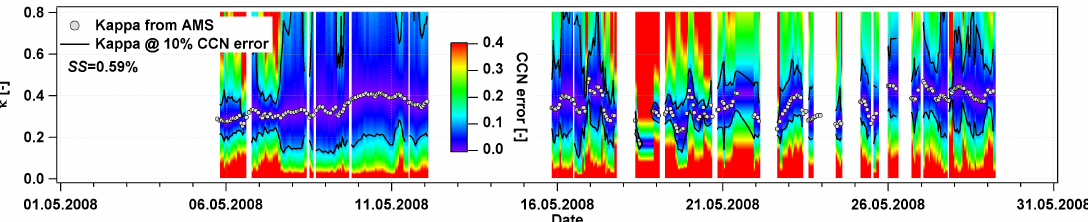
Fig. 7. Sensitivity of the prediction to the κ at 0.59% SS as a function of time. The grey dots show the AMS derived κ parameter. The different colours represent the relative change of the predicted CCN concentration as a function of the chosen κ .